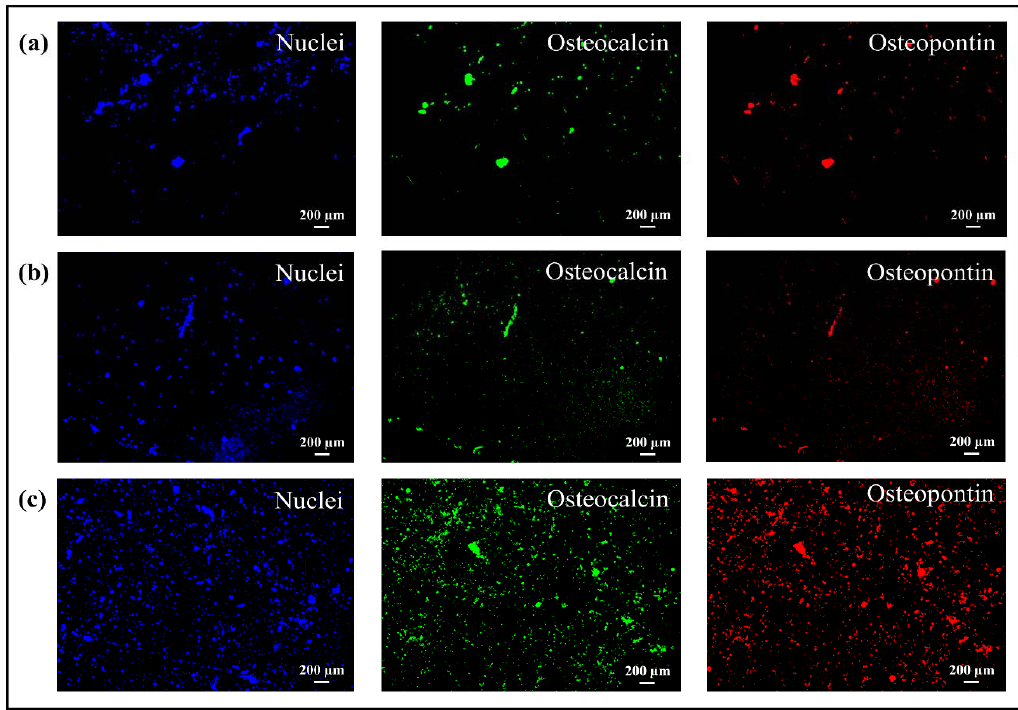
Figure 13. Fluorescence microscopy images collected on Ti-alloy ( a ), CS / PEO ( b ), and CS / PEO / BG ( c ) substrates: blue stain (osteoblast nuclei), red stain (osteopontin), and green stain (osteocalcin). Images collected at